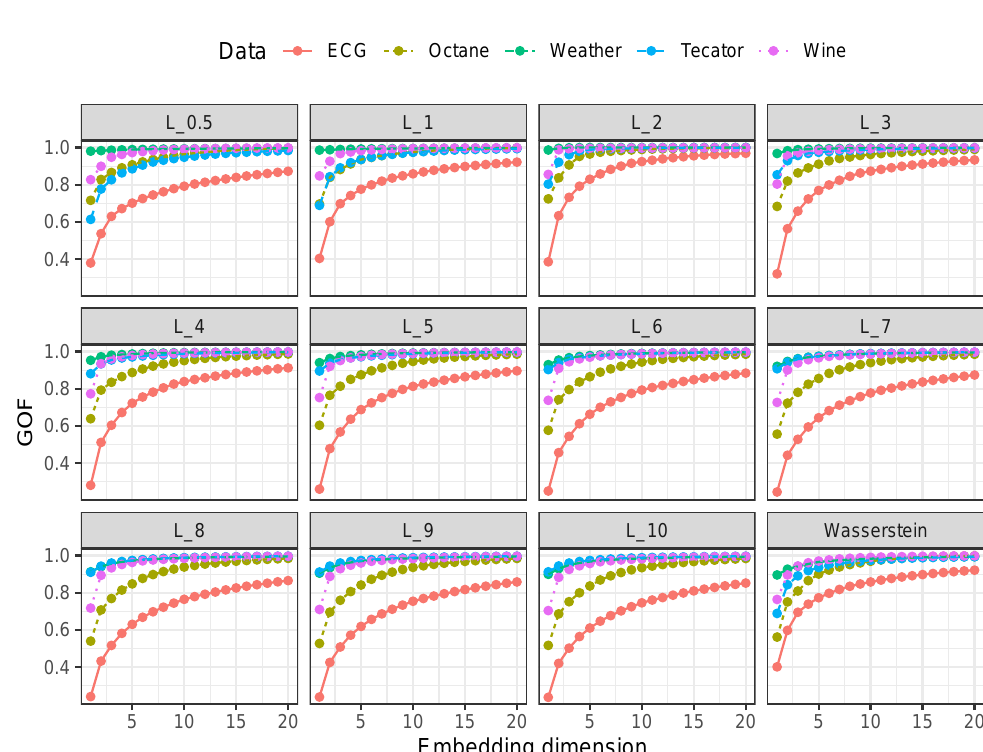
Figure A2. Goodness of fit (GOF) of different embedding dimensions for the five considered real datasets and L 0.5 , L 1 ,..., L 10 , and unnormalized L 1 -Wasserstein